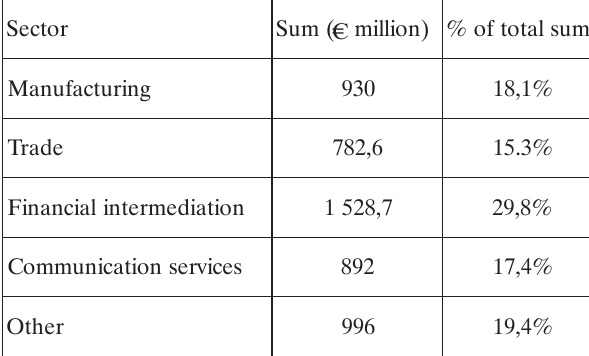
Table 2. FDI by sectors January 1, 2004 (Bank of